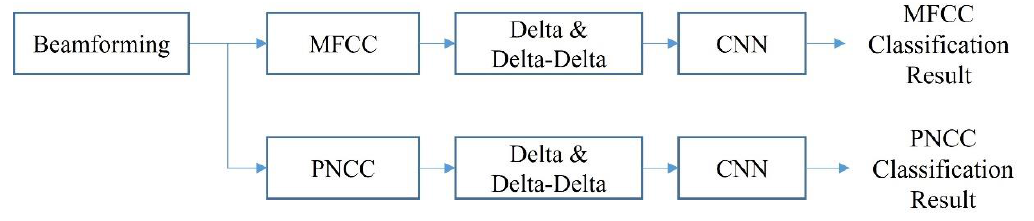
Figure 13. Structure for the experiment.